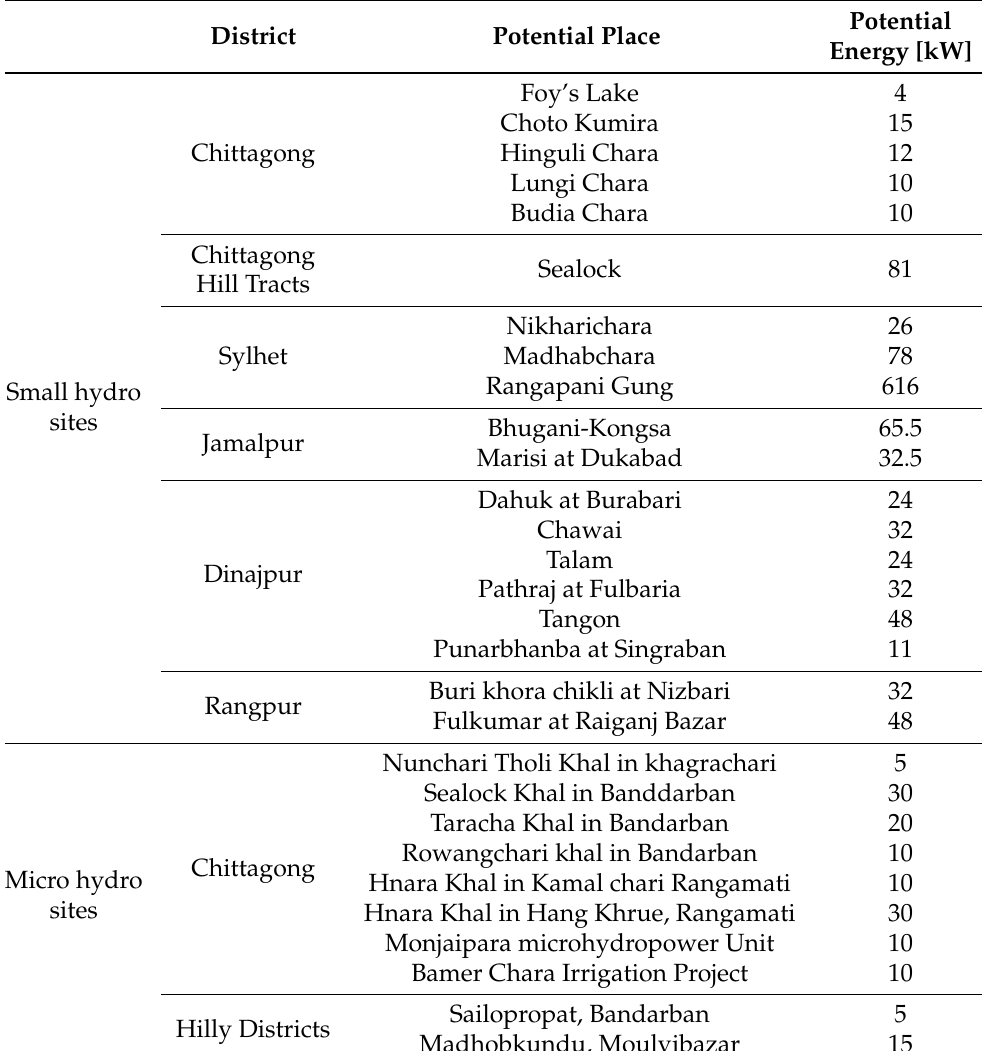
Table 5. Potential places for hydroenergy generation